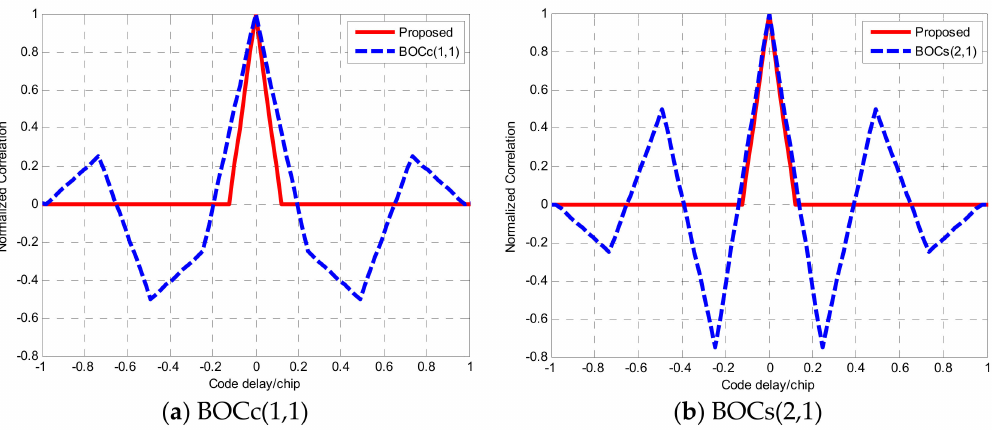
Figure 10. The reconstruction correlation function and